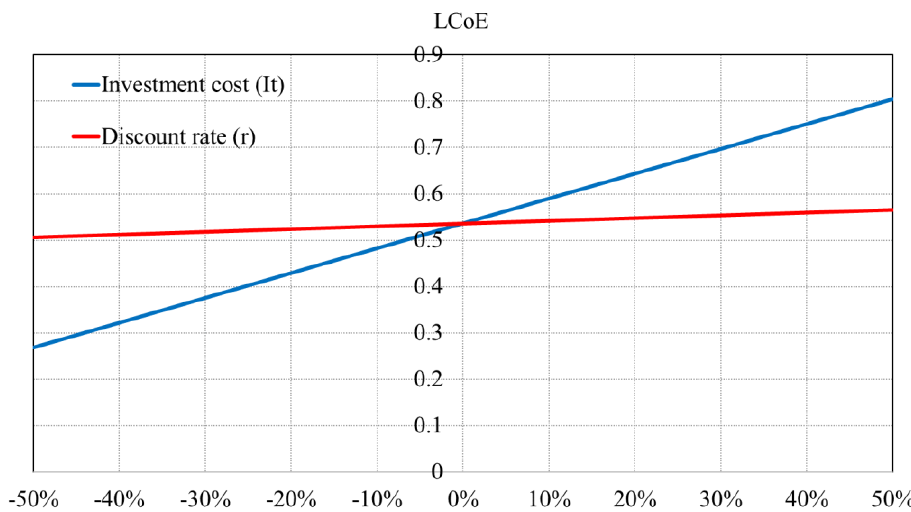
Figure 34. Sensitivity analysis on the LCoE of the BESS.